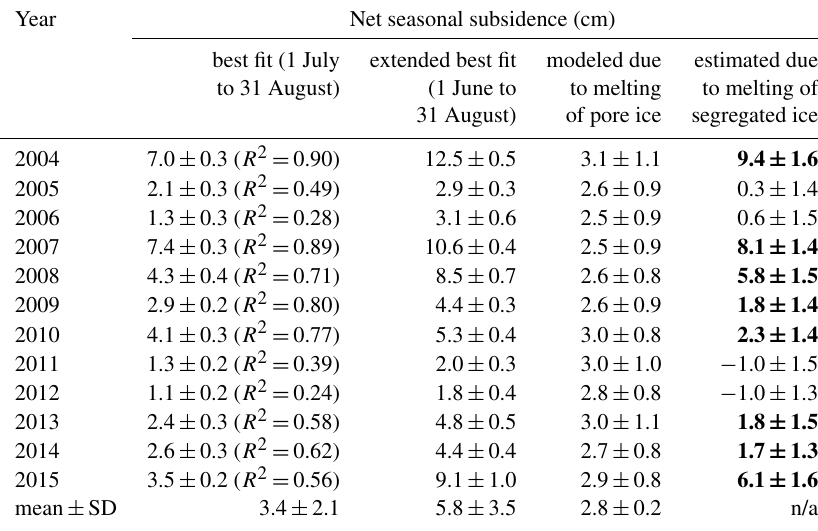
Table 3. Comparison among the best fit subsidence between 1 July and 31 August, extended best fit subsidence between 1 June and 31 August (i.e., entire thaw season), and the modeled maximum subsidence due to the melting of pore ice in the active layer. The R 2 values of the fit are listed in the parenthesis of the second column. The last column is the difference between the extended best fit and the modeled maximum subsidence, regarded as the net subsidence due to the melting of segregated ice. In the last column, the estimated subsidence values larger than the uncertainties are highlighted in bold. The last row lists the 12-year mean and the standard deviation